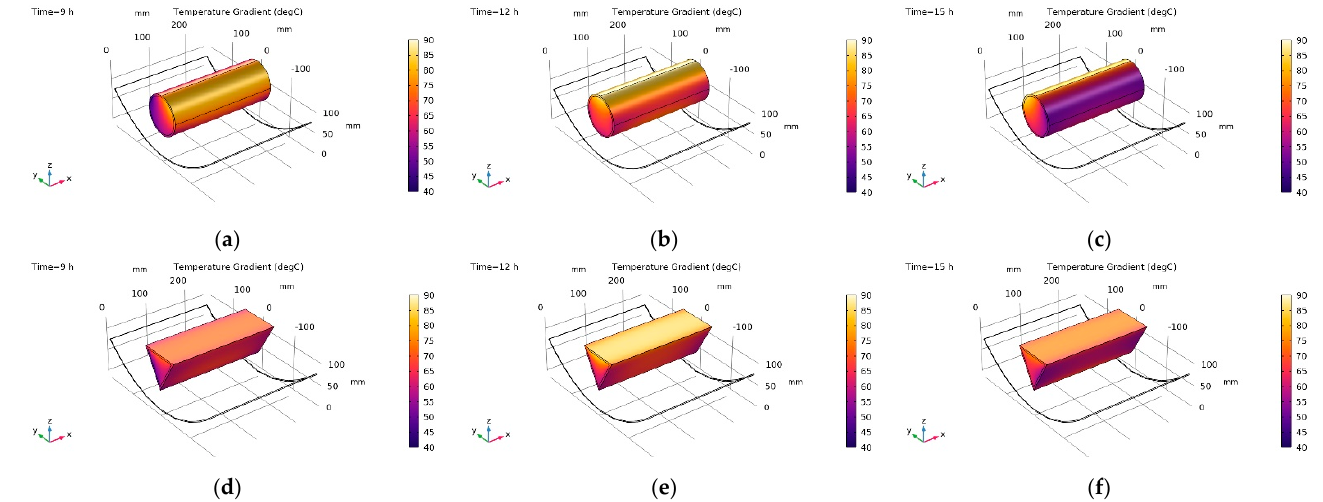
Figure 12. Three-dimensional plot of the temperature gradient of the circular SHC with a reflector at ( a ) 9:00, ( b ) 12:00, and ( c ) 15:00 and the temperature gradient of the triangular SHC with a reflector at ( d ) 9:00, ( e ) 12:00, and ( f ) 15:00.